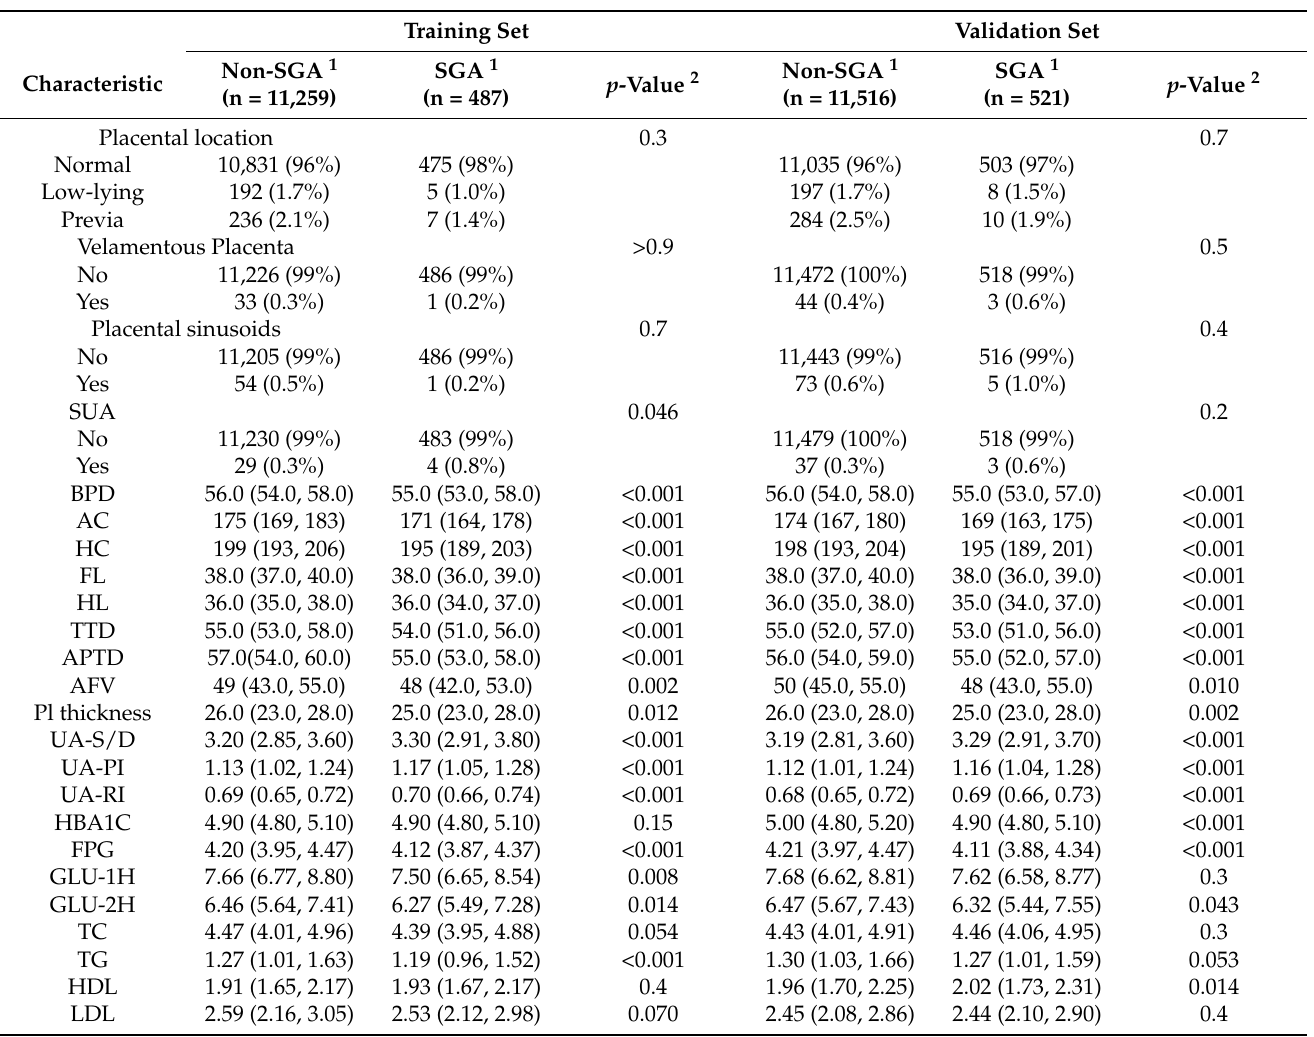
Table 2. Medical